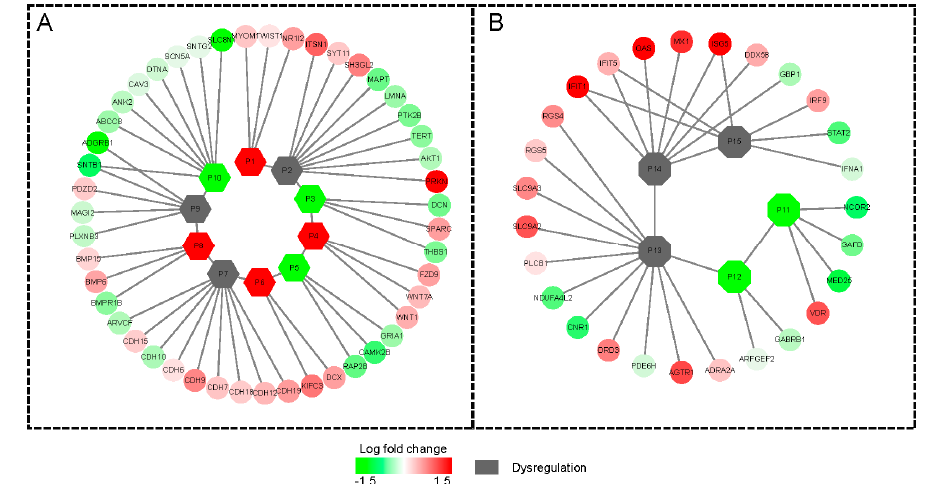
Figure 10. The potential anticancer mechanism and cardiotoxicity of bufadienolide-like chemicals. ( A ) The potential anticancer mechanism of bufadienolide-like chemicals. Nodes p1–p10 means the 10 differentially regulated sub-networks in Figure 7. ( B ) The potential cardiotoxicity